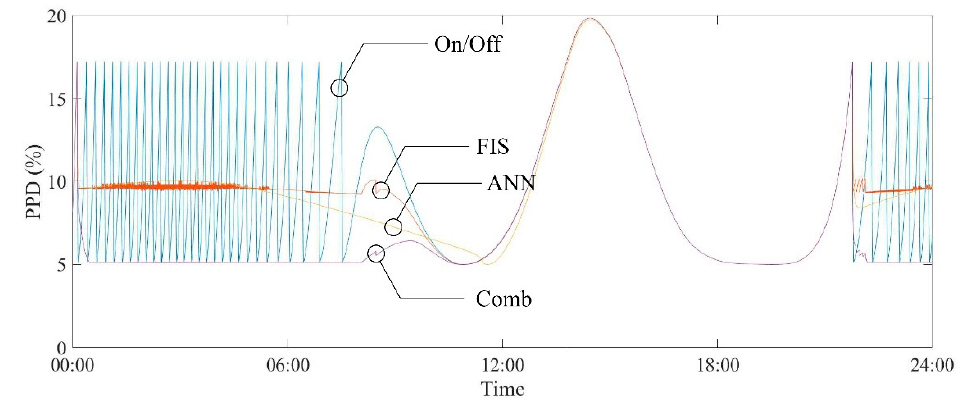
Figure 6. Thermal dissatisfaction at a normal condition.